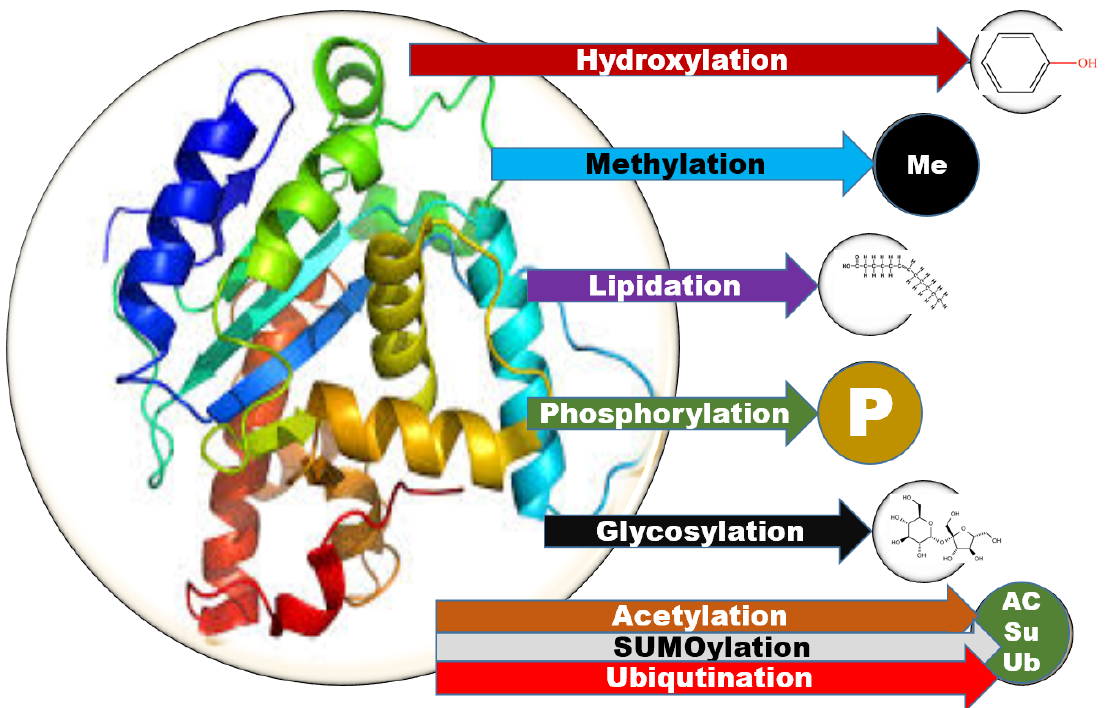
Figure 1. Schematic showing the wide range of post translational modification of proteins of biological significance.